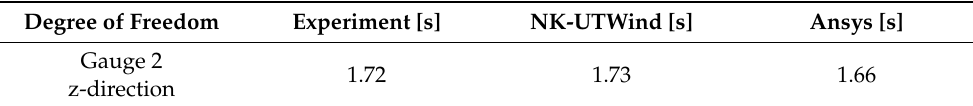
Table 6. Most energetic vibration modes obtained from the hammering test. Degree of